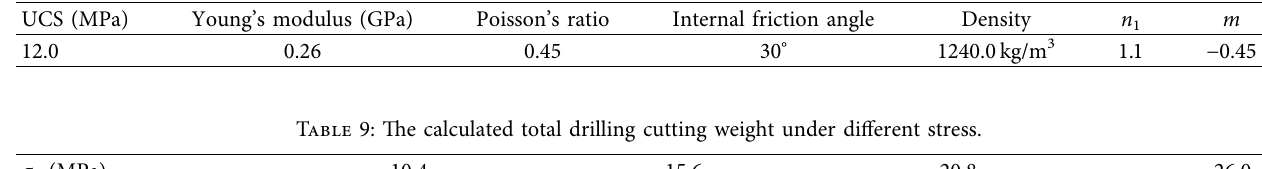
Table 8: The mechanical parameters of coal body in Longfeng Coal Mine.